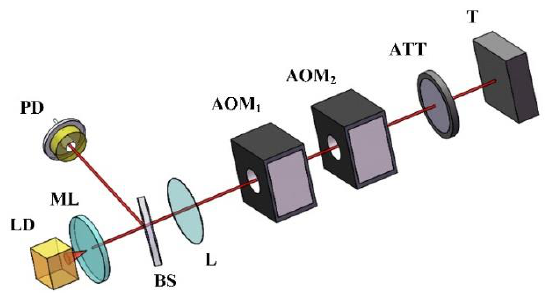
Figure 1. Schematic diagram of the laser frequency-shifted optical feedback interferometer. LD: laser diode; ML: microchip Nd:YVO 4 laser; BS: beam splitter; PD: photon detector; L: lens; AOM 1 , AOM 2 : acousto-optic modulators; ATT: attenuator; T: target.